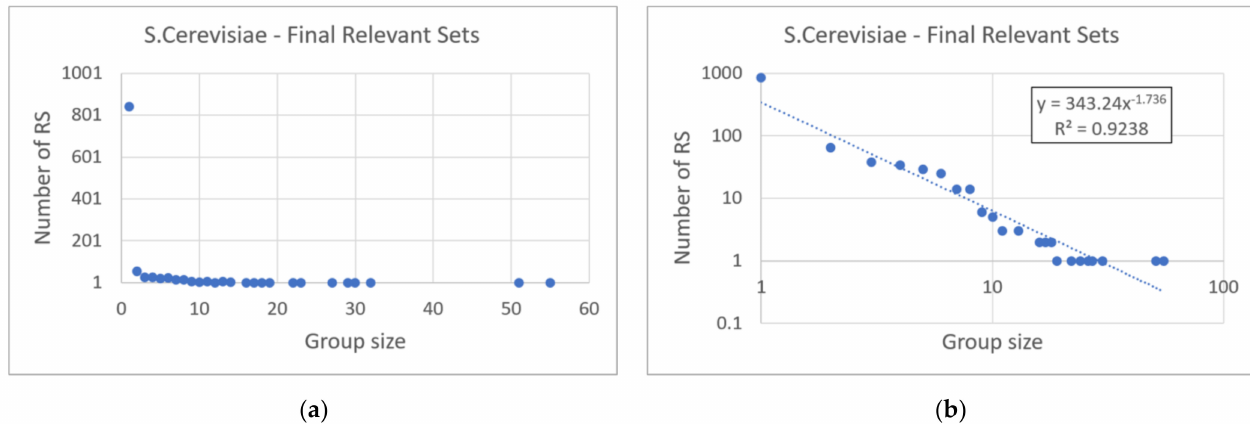
Figure 9. The size distribution of the RSs found in X ( a ) Linear plot. ( b ) Log-log